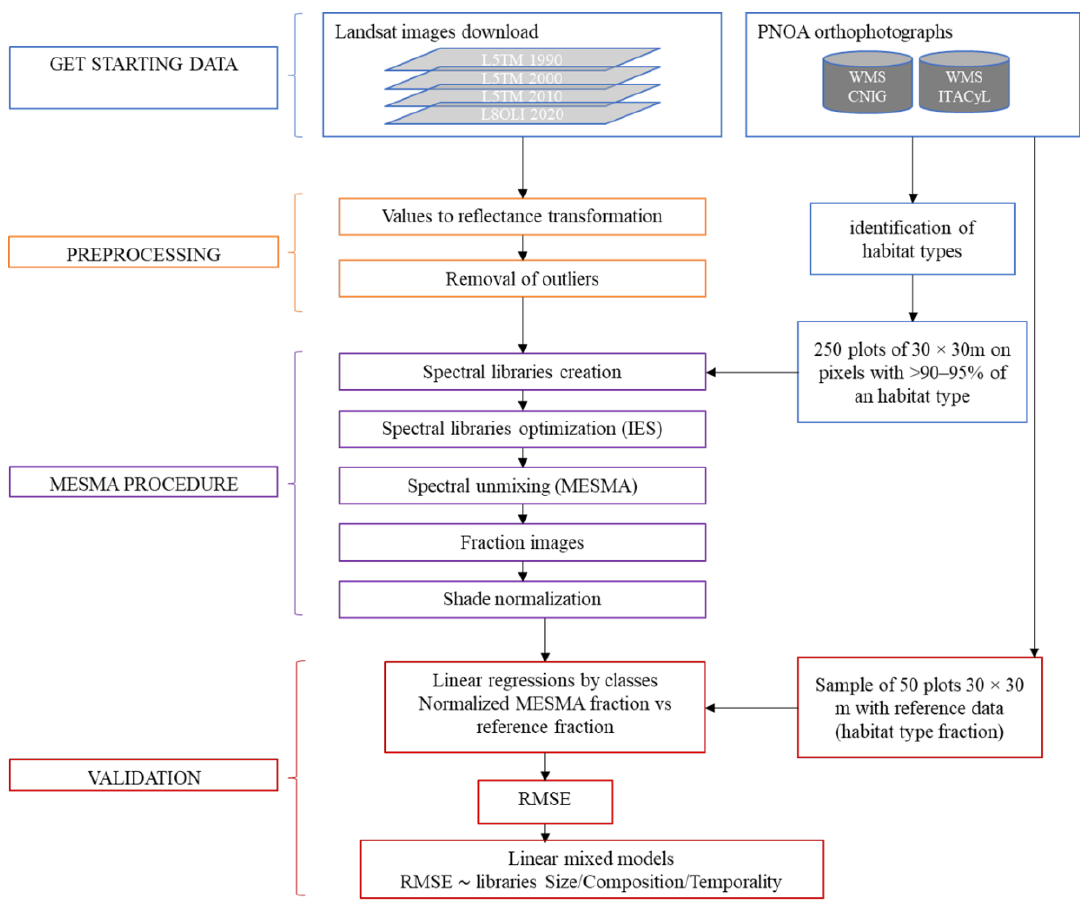
Figure 3. Methodology flow chart. WMS: web map service; CNIG: National Geographic Information Centre; ITACyL: Agricultural Technological Institute of Castile and Leon; IES: iterative endmember selection; MESMA: multiple endmember spectral mixture analysis; RMSE: root mean square error.